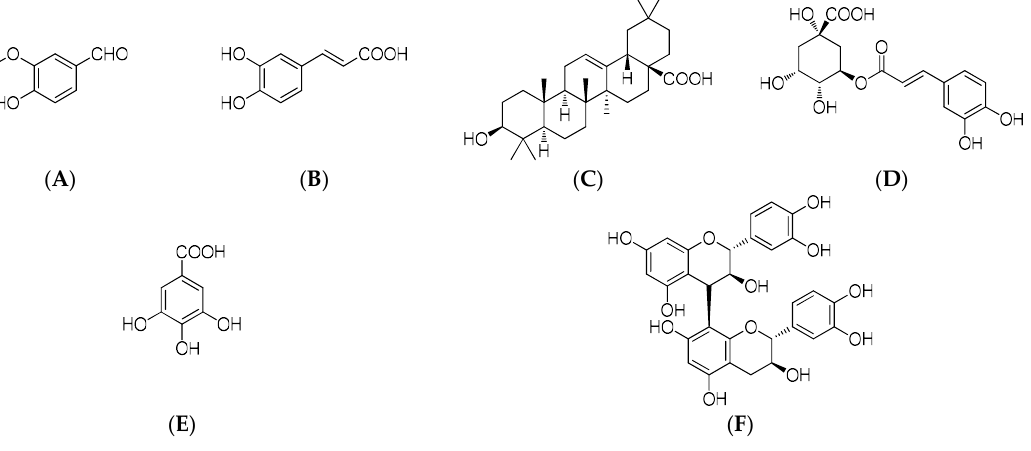
Figure 2. Chemical structures of detected compounds in MPE. ( A –vanillic aldehyde; B –caffeic acid; C –oleanolic acid; D –chlorogenic acid; E –gallic acid; F –procyanidin B 2 ).